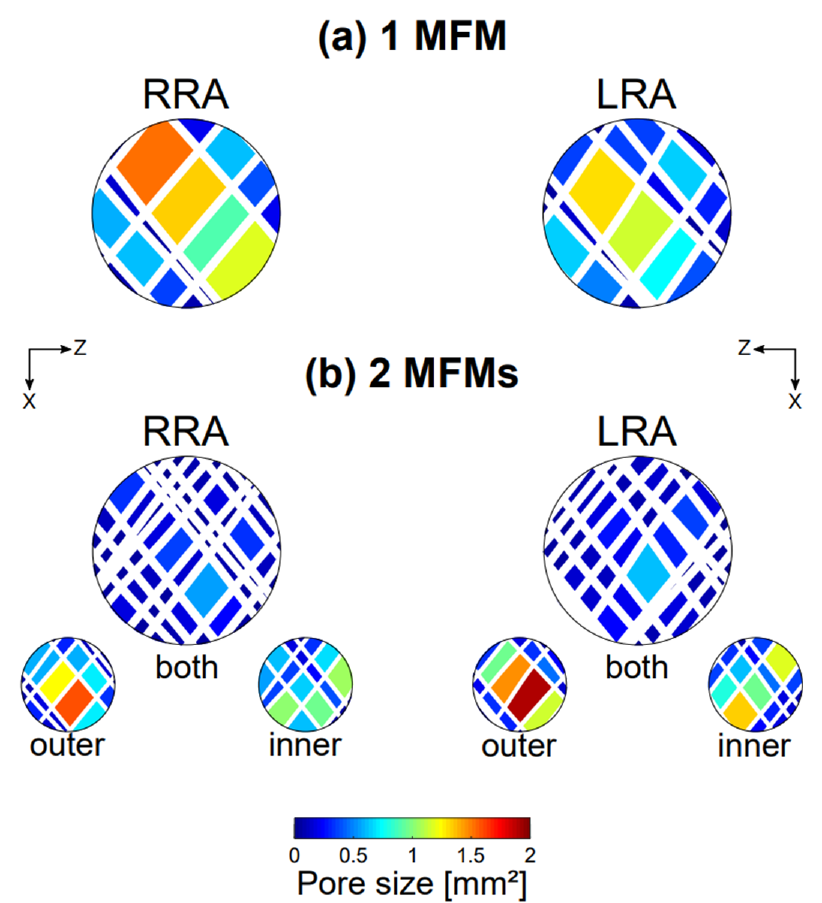
Figure 4. Pore size evaluation on MFM devices extracted geometries. ( a ) single and ( b ) overlapped case. Diameter of the extracted ROI is 4 mm. Table 1. Microstructural parameters evaluated on the extracted MFM geometries. Pore size values are reported as weighted mean ± weighted standard deviation.